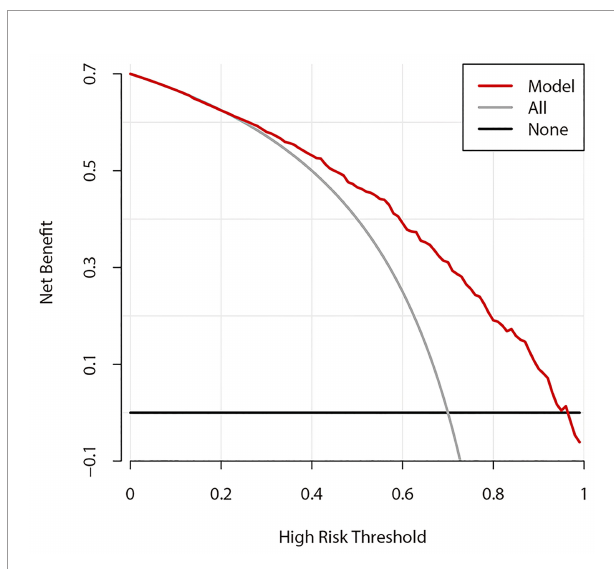
FIGURE 6 | Decision curve analysis of prediction model